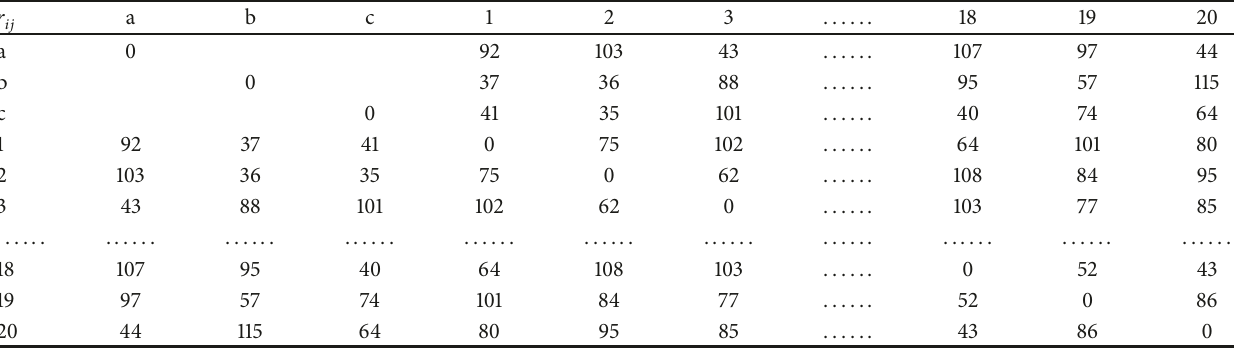
Table 3: The nominal transportation time value of hazamt.